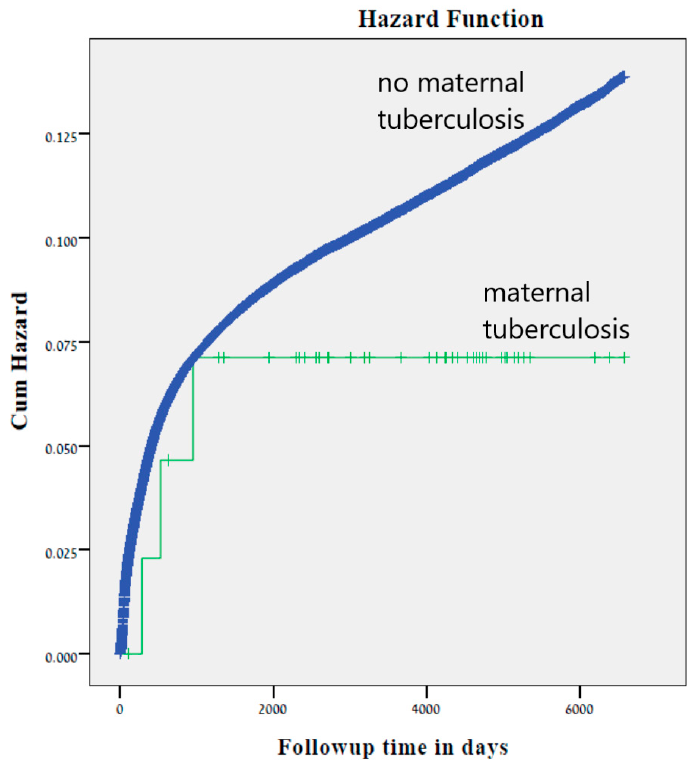
Figure 1. Kaplan Meier survival curve demonstrating the cumulative incidence of infectious hospitalizations according to pregnancy with and without maternal tuberculosis (Log-Rank test p = 0.423).